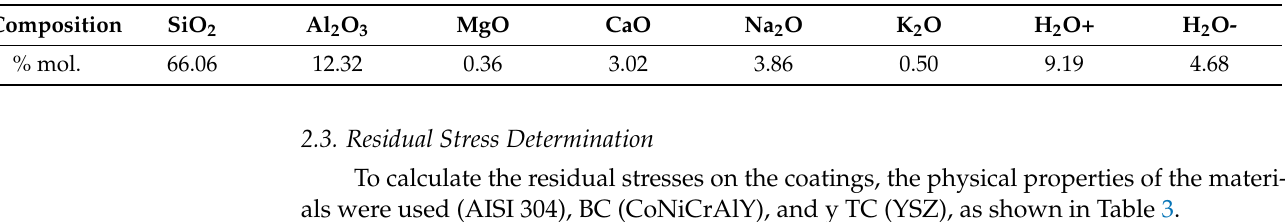
Table 2. CMAS chemical composition (mordenite).